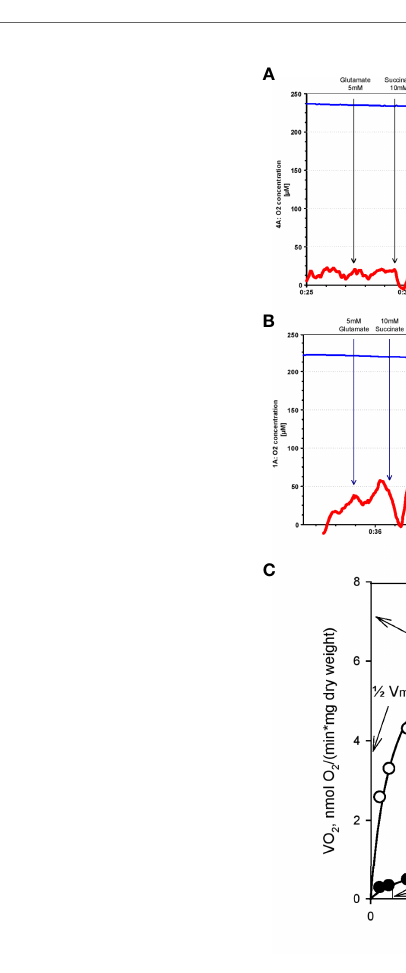
FIGURE 1 | Michaels-Menten kinetics of ADP-dependent respiration of human colorectal cancer and polyp biopsy material. Representative tracing of adenosine diphosphate (ADP)-activated oxygen consumptions rates in human permeabilized tissue of (A) colorectal polyp and (B) and colorectal cancer. (C) Corresponding Km (ADP) and V max values were calculated by non-linear regression using the Michaelis-Menten